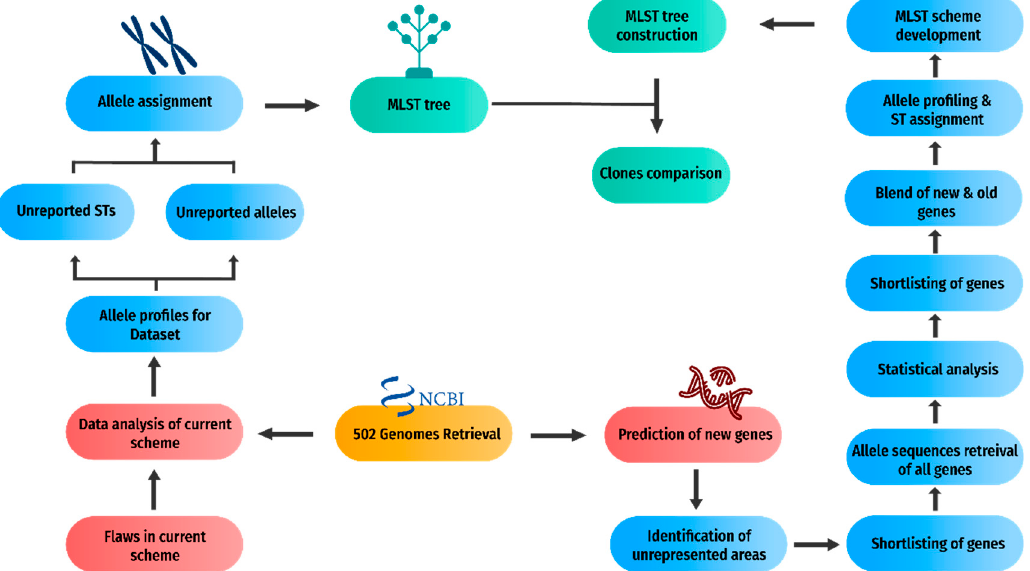
Figure 3. Development of a new MLST scheme. The flowchart demonstrates the second component of the methodology, the development of a new MLST scheme, in detail.